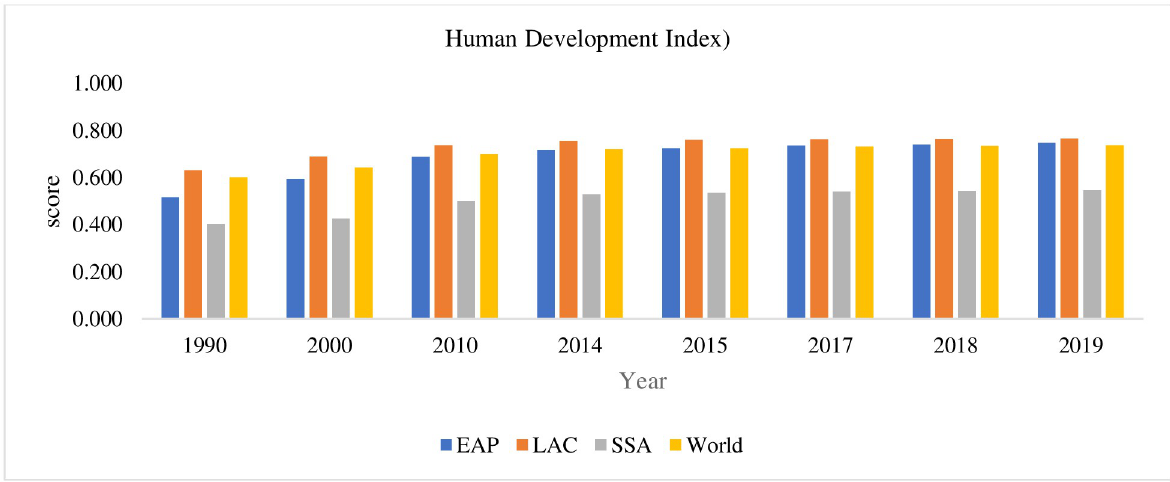
Fig 3. Human Development Index (HDI). Source: Researchers’ Compilation, using Human Development Indicators (2020).